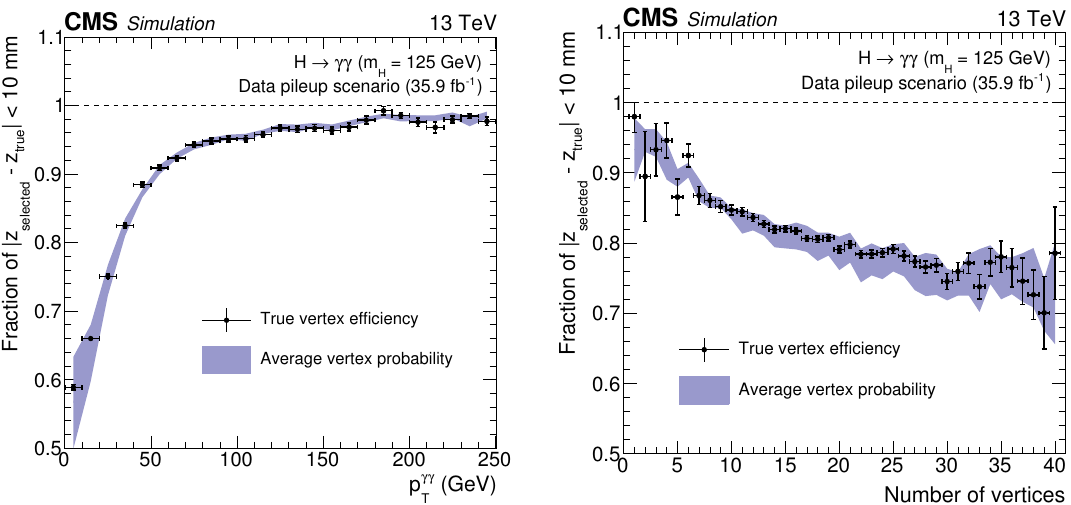
Figure 4 . Comparison of the true vertex identi(cid:12)cation e(cid:14)ciency and the average estimated vertex probability as a function of the reconstructed diphoton p T (left) and of the number of primary vertices (right) in simulated H ! (cid:13)(cid:13) events with m H = 125 GeV. Events are weighted according to the cross sections of the di(cid:11)erent production modes and to match the distributions of pileup and location of primary vertices in